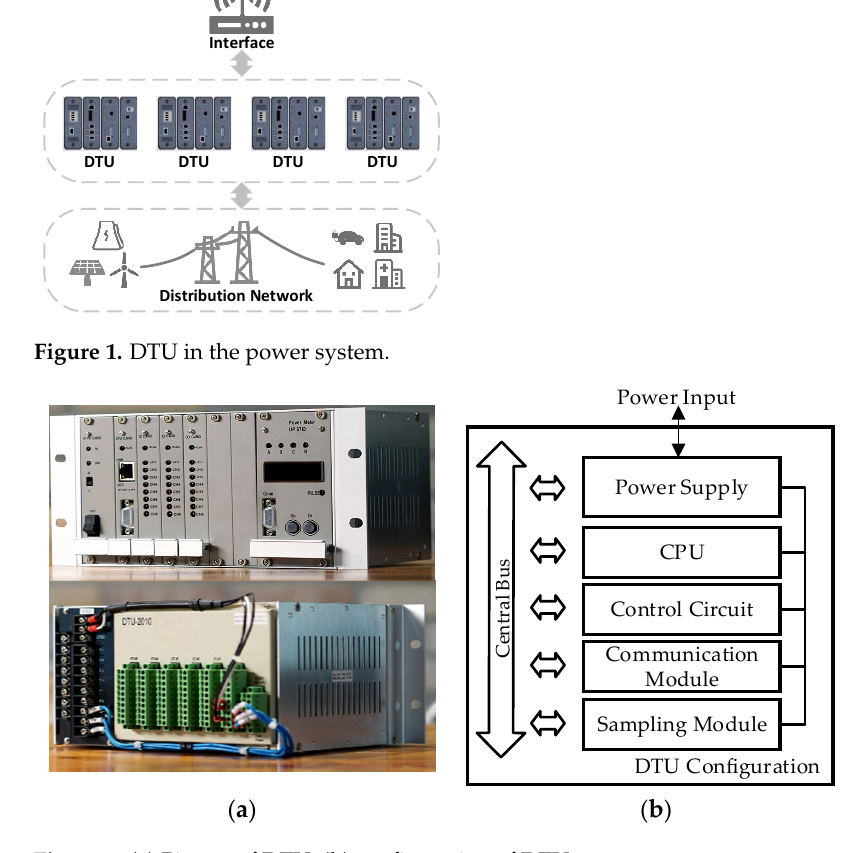
Figure 1. DTU in the power system.